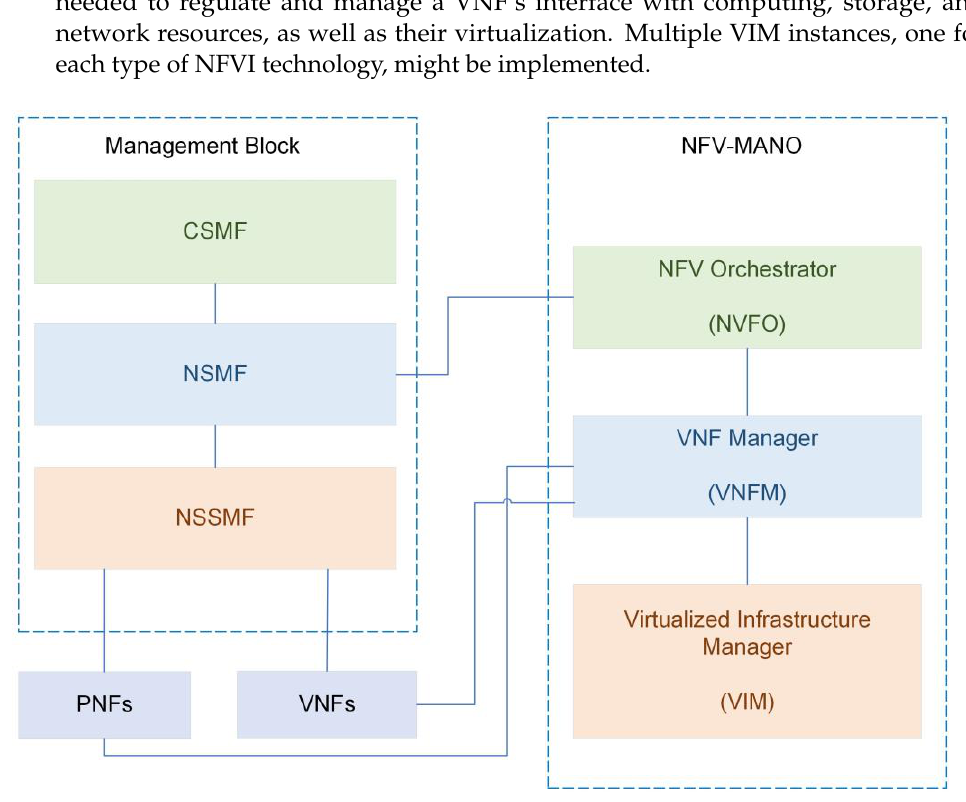
Figure 5. Fifth-generation orchestration with ETSI NFV. The NSMF is a domain orchestrator responsible to manage the slices in multiple domains and integrates to NSSMF in the core, access, and transport as well. It might function as a northbound system to the NFVO while the NFMF continues to perform its normal functions, such as integrating with VNFs and PNFs